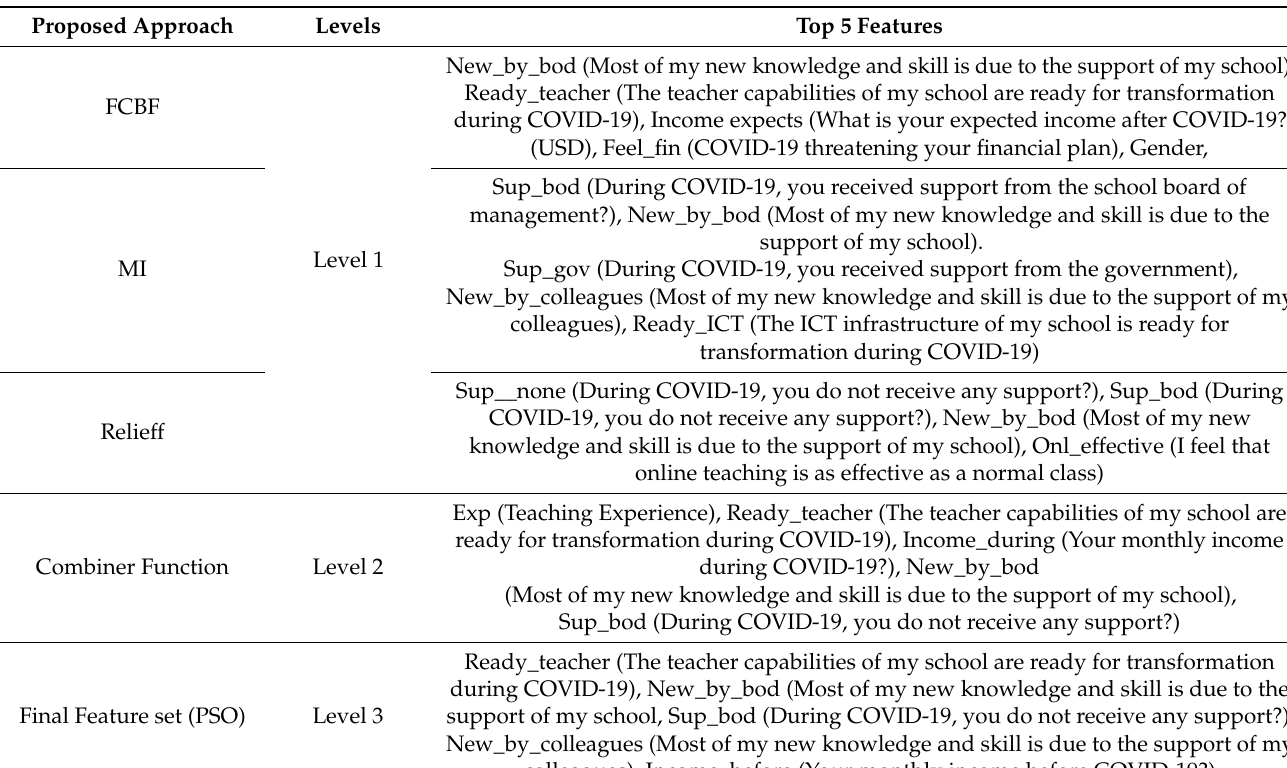
Figure 2. Flow of Results for Covid Teacher Dataset. Table 3. Feature Selection Analysis of Proposed